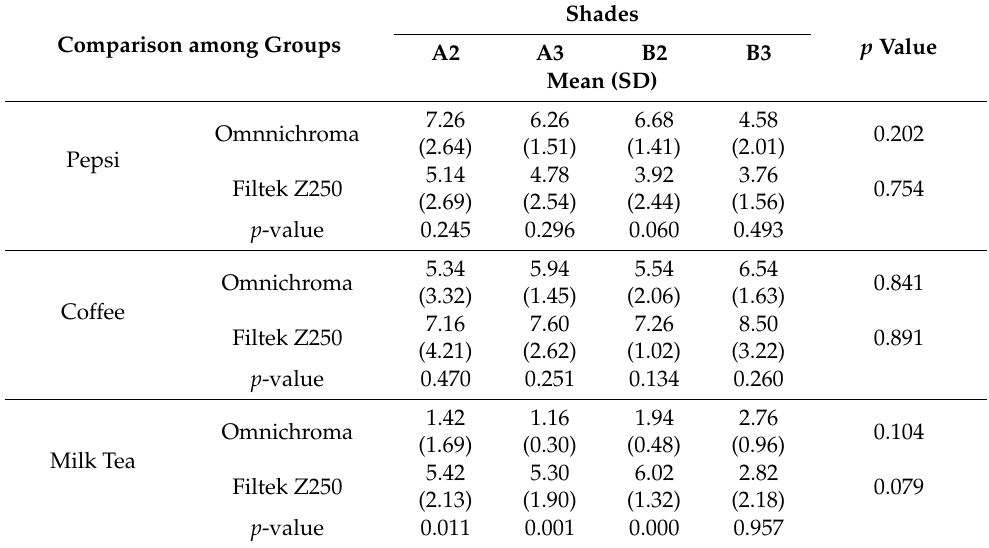
Table 2. Mean difference in ∆ E values of the samples before and after immersion in different beverages.